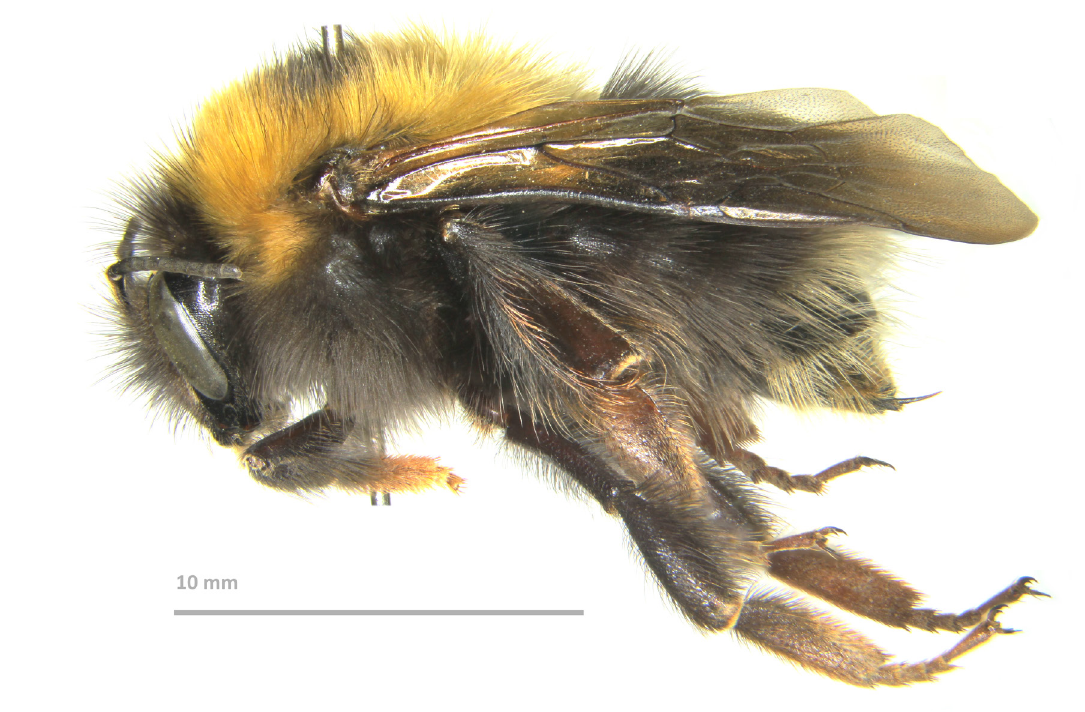
Fig. 51. Bombus wolongensis Williams, Ren & Xie sp. nov., ♀ (queen), holotype (IOZ), habitus, lateral view (image reversed). Scale bar: 10